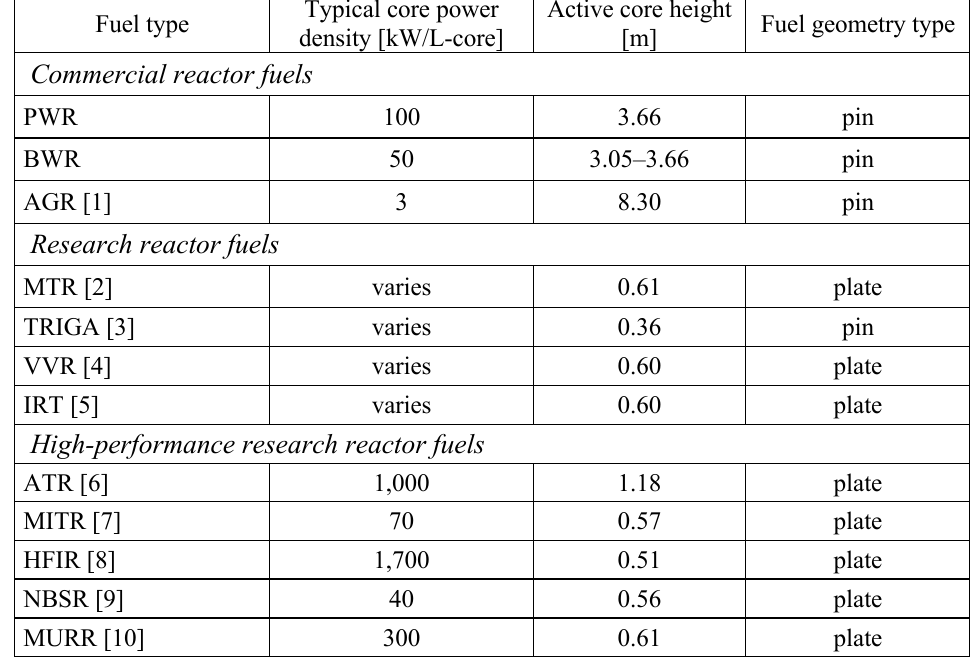
Table I. Power densities, fuel geometries, and active core height for selected reactor